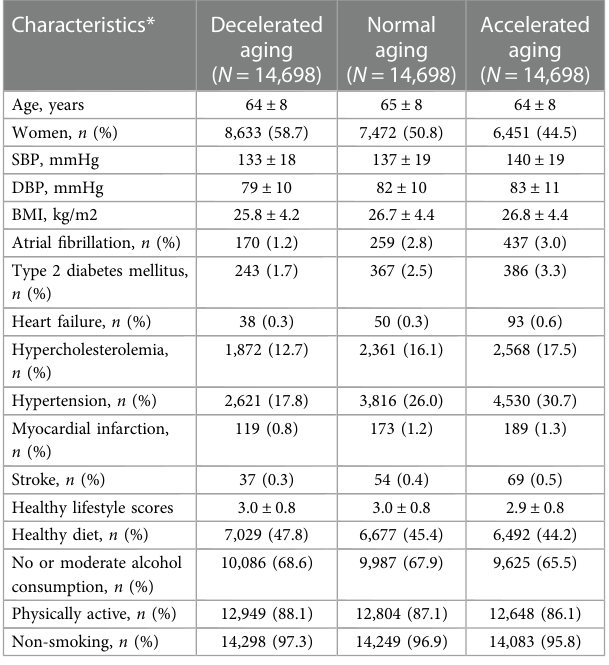
TABLE 1 Clinical characteristics of study participants ( N